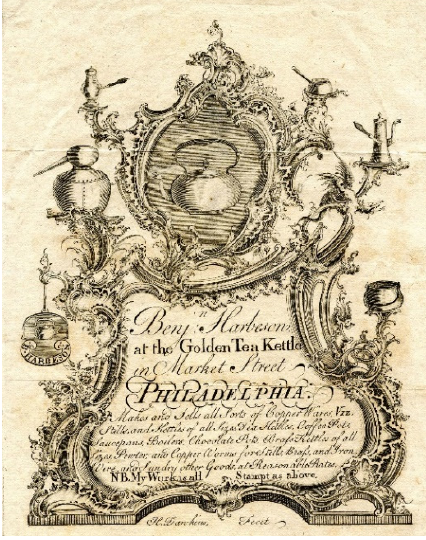
Figure 4. Henry Dawkins (England and USA 1753-ca. 1786), Trade Card for Benjamin Harbeson’s copperware business , 1776, Engraving, 9.65 cm × 7.08 cm, The Winterbur Library, Delaware.